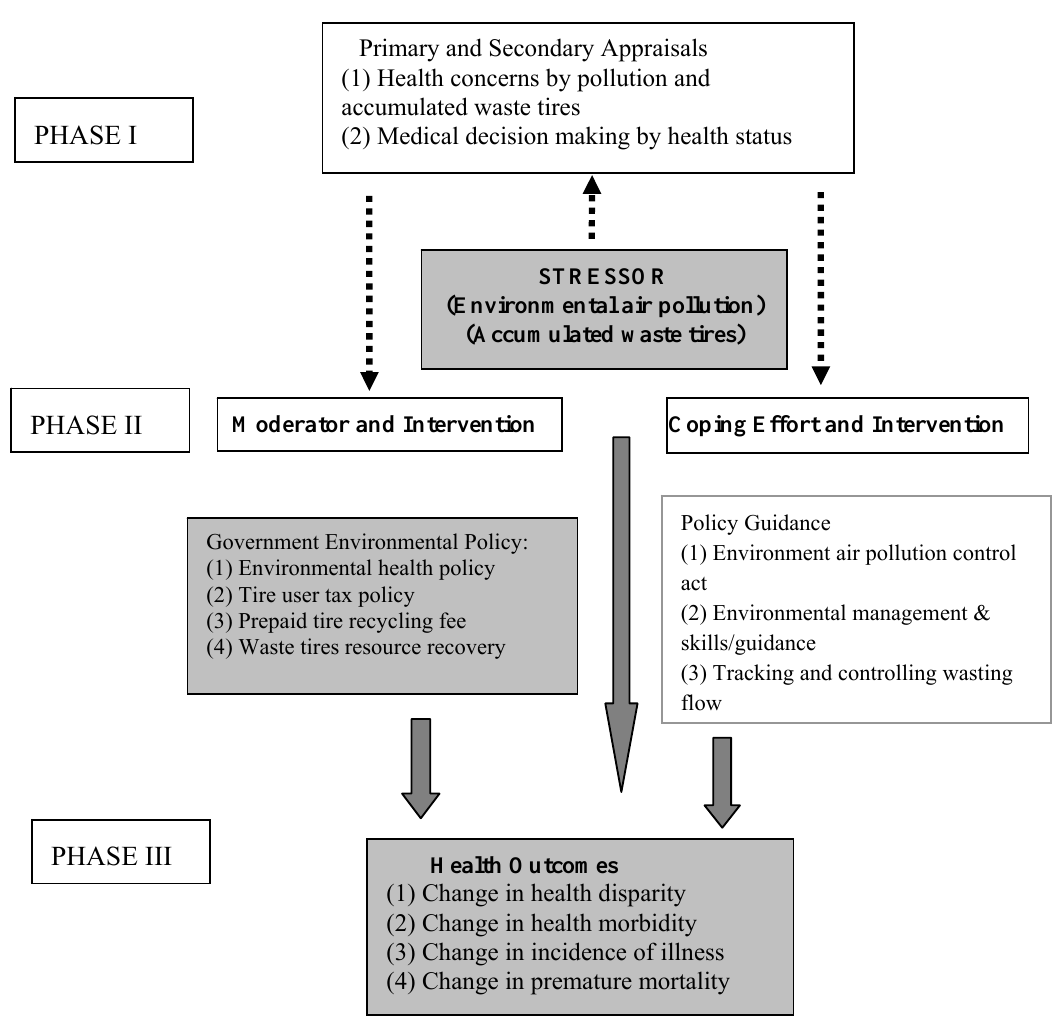
Figure 1. Application of the Transactional Model to Environmental Health Hazard, Government Health Policy, and Health